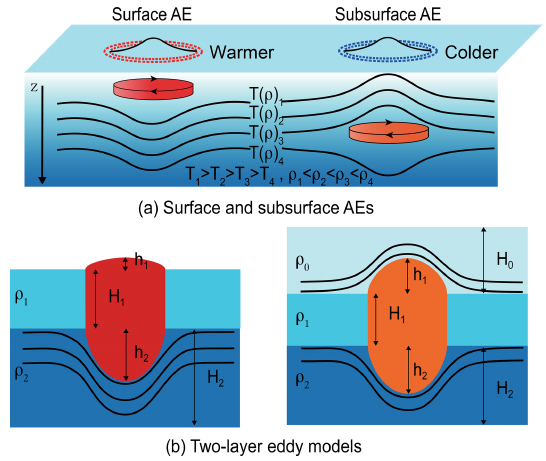
Figure 1. (a) Surface and subsurface anticyclonic eddies (AEs) and (b) two-layer eddy models used in the present